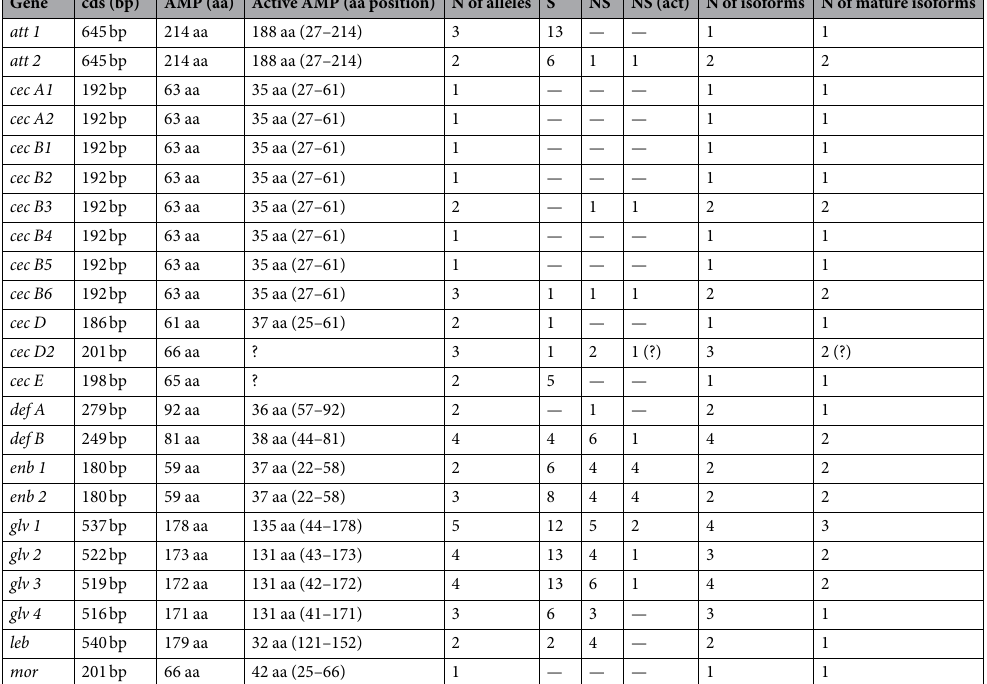
Table 2. AMP alleles and isoforms in the four B . mori strains. cds: length of the coding sequence; S: number of synonymous substitutions; NS: number of non-synonymous substitutions; NS (act): number of non- synonymous substitutions in the active portion of the peptide; (?): missing information on the precise position of the active sequence of the